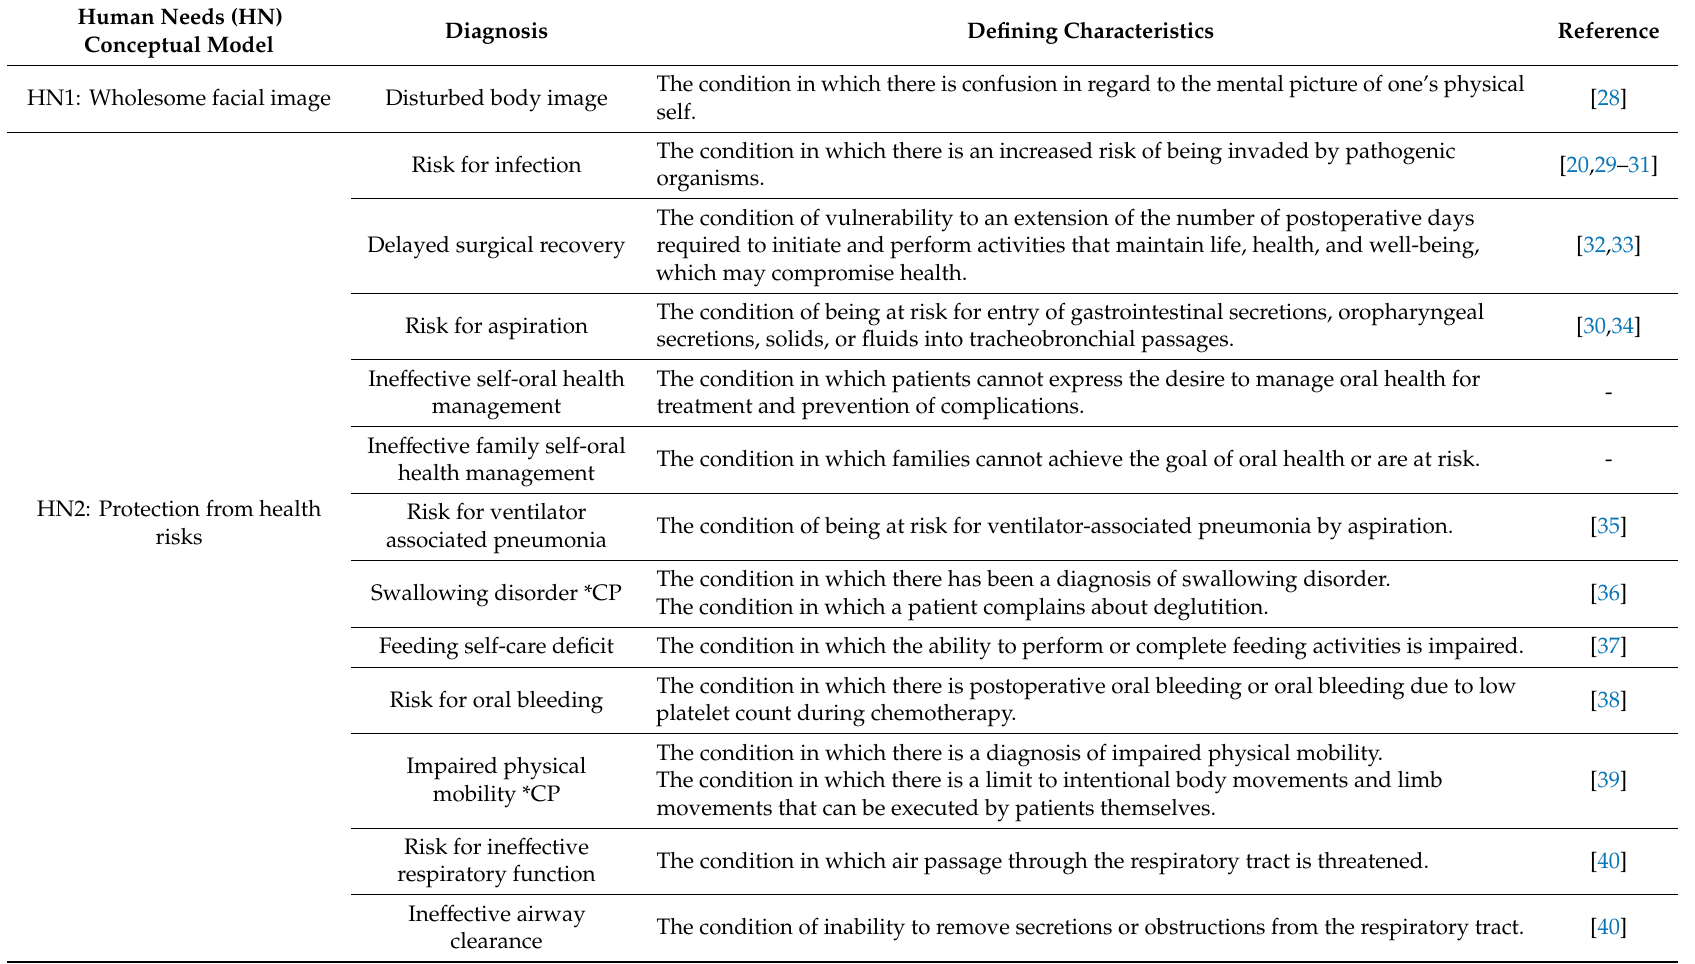
Table 3. Proposal of dental hygiene diagnosis categories in cancer treatment in an acute care